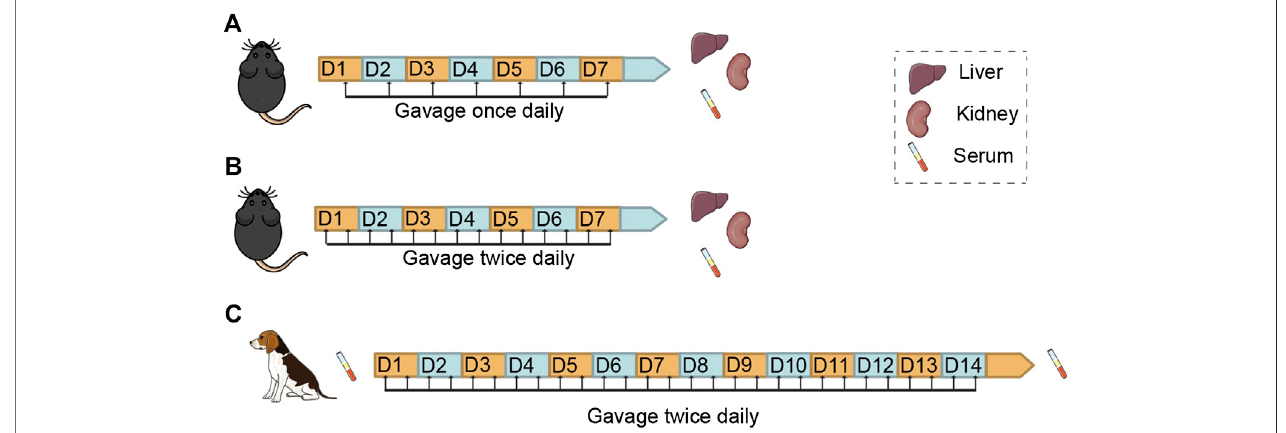
FIGURE 1 | Study Design for the Examination of Subacute Toxicity of Nicotinamide Mononucleotide (NMN) in Mice and Dogs Schemes showing the route, frequency and duration of NMN administration and sampling in mice. (A,B) and beagle dogs (C) .